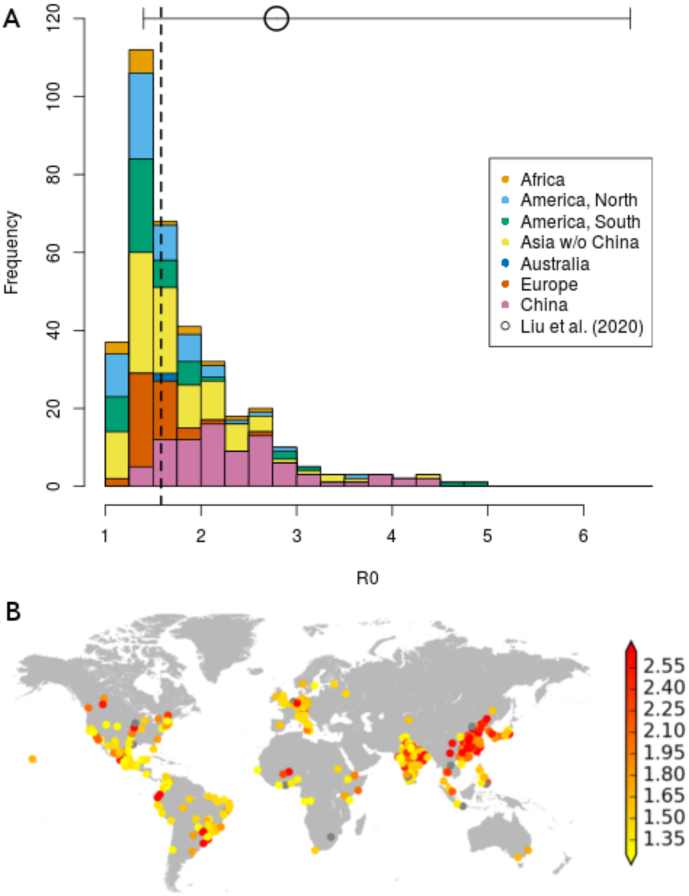
Calculated values of R0 over the exponential growth period for world cities with at least half a million inhabitants. A) Frequency histogram of R0 values calculated for 359 cities. Colour indicates continent, with China highlighted separately. Dashed line indicates median R0 value. The circle with horizontal bars indicates median, min and max of R0 values, as collected by Liu et al. [29]. B) Mapped locations of all 374 cities examined. Colour indicates R0 value, with grey dots indicating excluded cities (see SM Section S4.8).